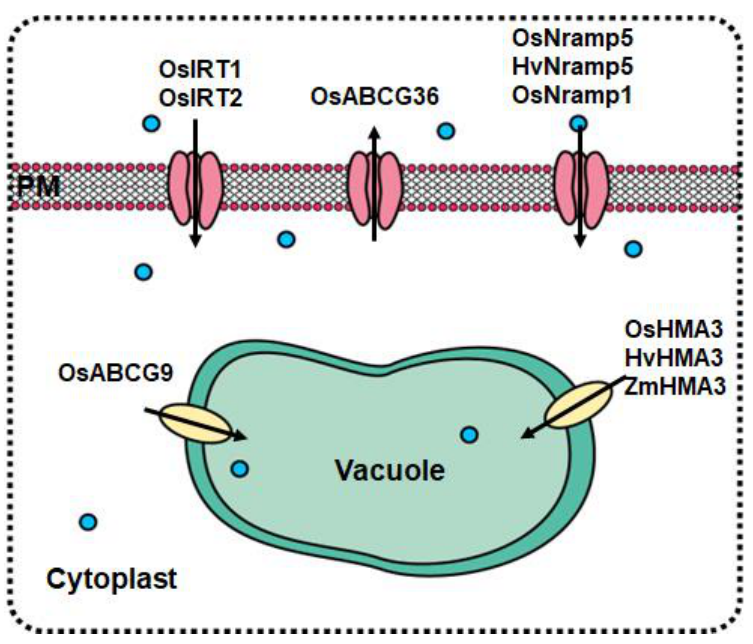
Figure 1. Schematic diagram of main Cd transporters involved in Cd uptake, efflux and vacuolar sequestration in root. PM, plasma membrane.